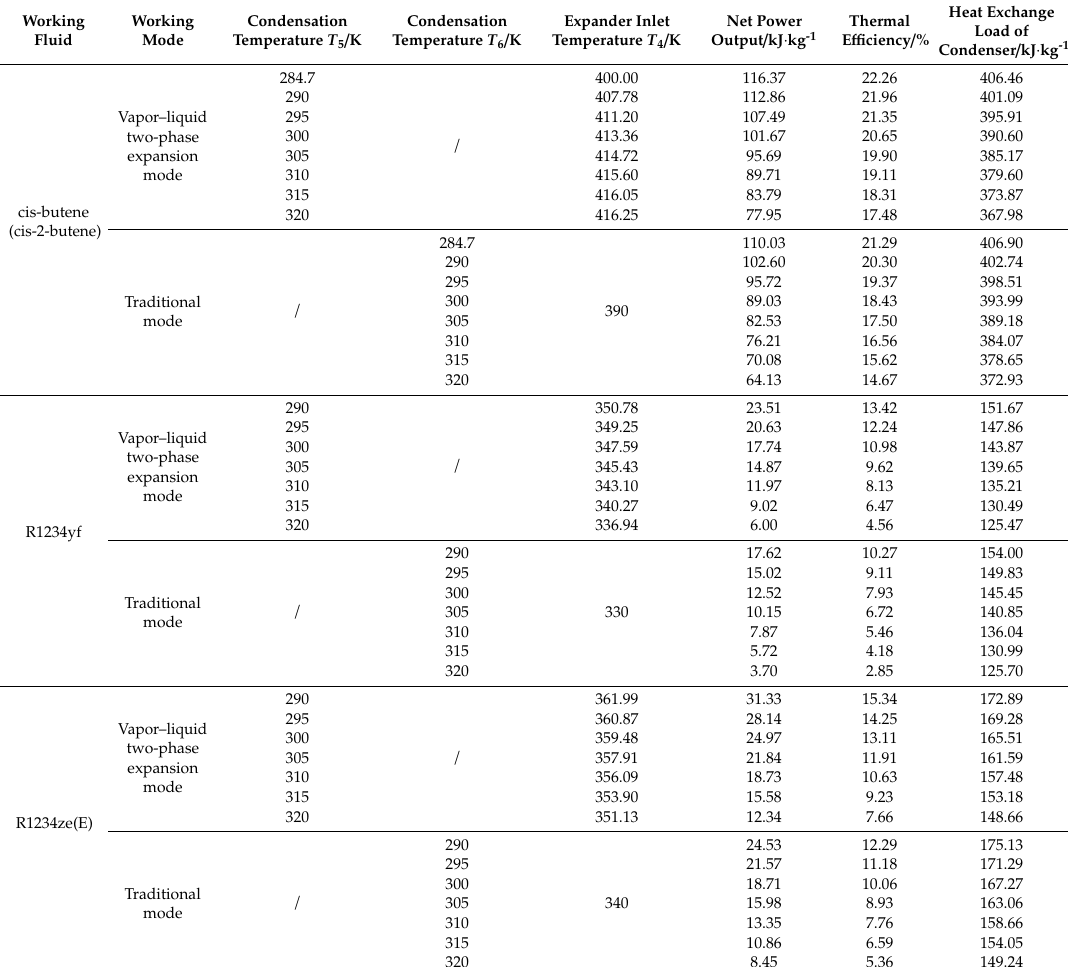
the condensation temperature is